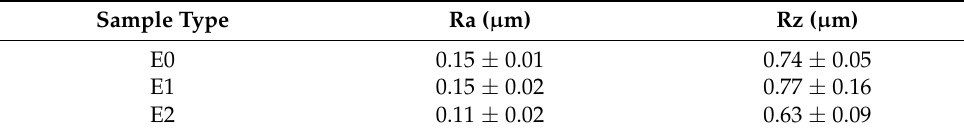
Table 1. Surface roughness measurements (in-plane measurements).